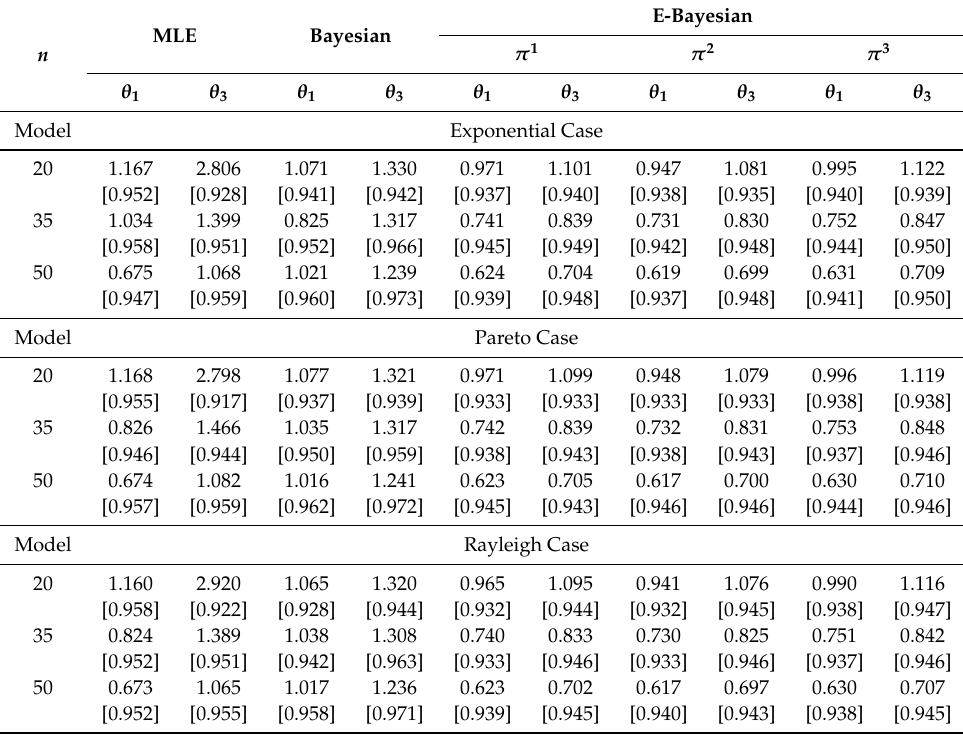
Table 2. The ALs and CPs (within bracket) of interval estimates with ( c 1 , c 2 , c 3 ) = ( 1.5,2,1.2 )